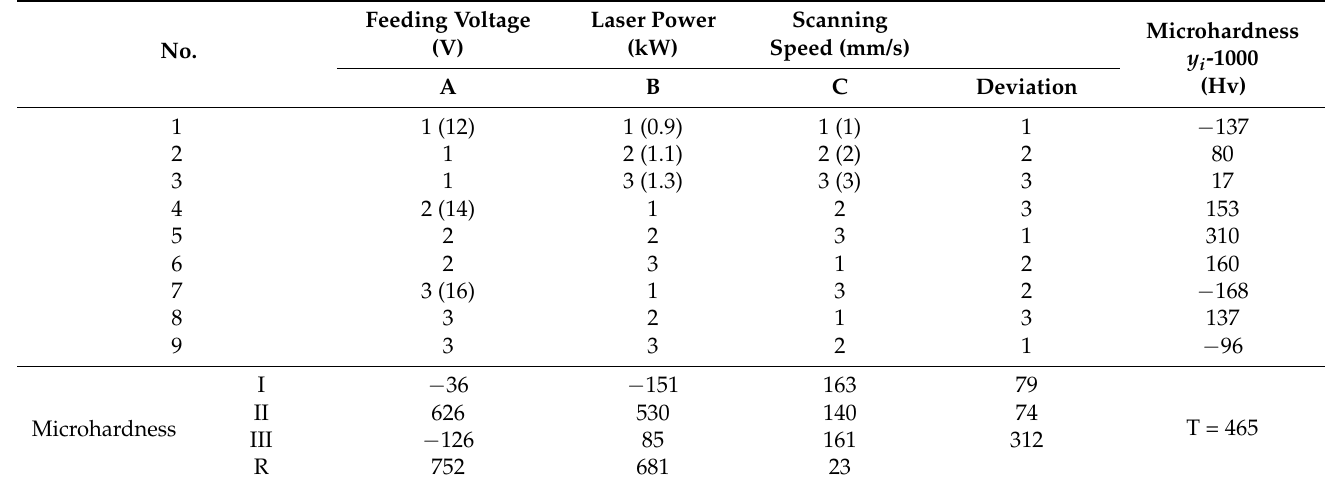
Table 5. The orthogonal test table and experimental